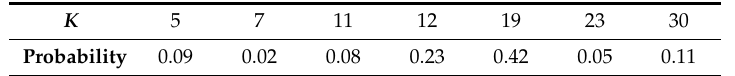
Table 4. The probability mass function of random variable K for our third example.